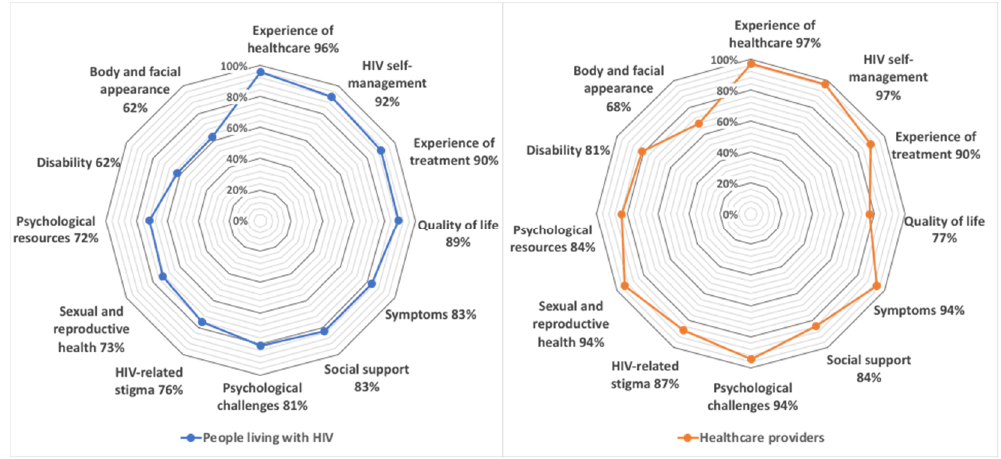
Figure 4. Participant interest in types of HIV-specific PROMs for administration via Opal.